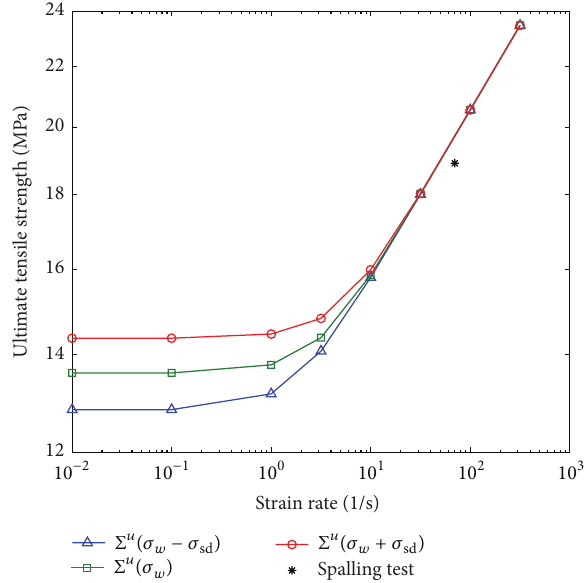
Figure 7: Ultimate strength in granite as a function of the strain rate in logarithmic scale based on the DFH model using the multiscale description and three values of random stress 𝜎 𝑘 .